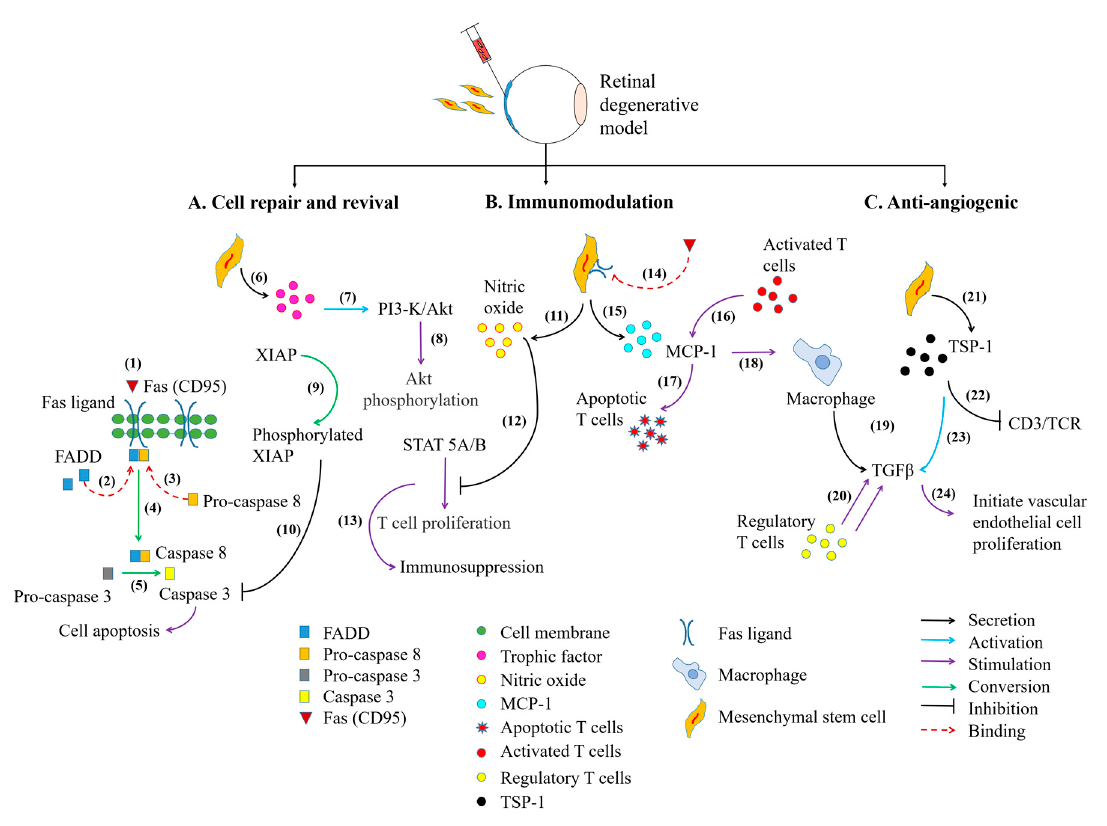
Figure 3. The signaling pathways involved in MSC-mediated therapeutic strategies in the eye. The cell death machinery involves ( 1 – 2 ) the binding of Fas/Fas ligand, which assembles Fas-Associated protein with Death Domain (FADD) to form a docking site for pro-caspase 8. This event initiates the ( 3 – 4 ) crosslinking of pro-caspase 8 to FADD and activates caspase 8. Activated caspase 8 ( 5 ) induces